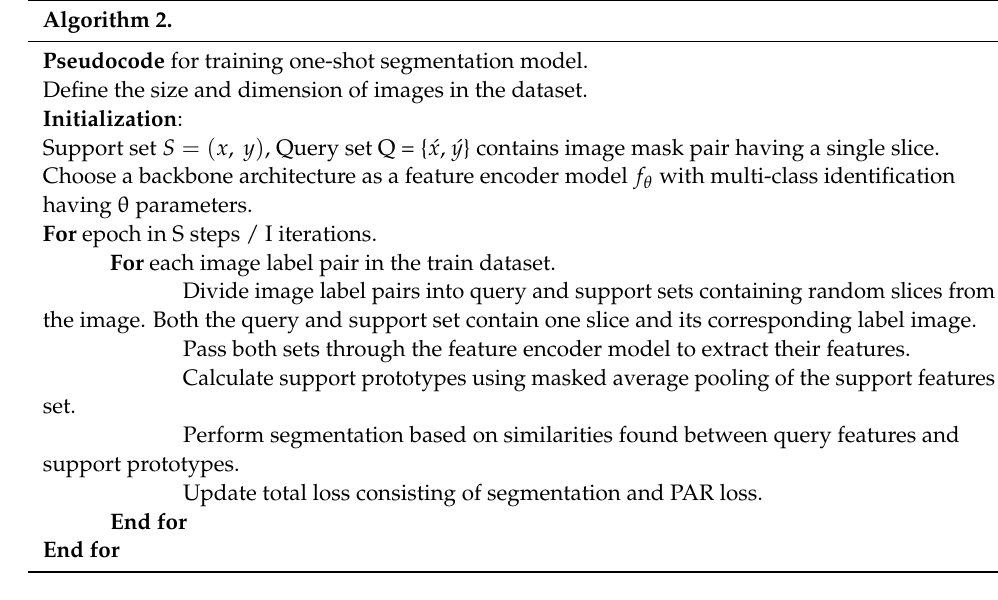
Figure 3. Demonstration of the procedure for determining the portion of the tumor in each slice. Here, the first column of each image contains the serial number according to the BraTS dataset and the corresponding random slice with an intensity threshold > 0.5. The second column contains the corresponding label of each scan. The third column depicts the layered structure of labels highlighting tumor levels, area, and mean intensities (MI). The fourth column contains the binarized form of label data. Algorithm 1. Foreground prototypes based on few-shot segmentation